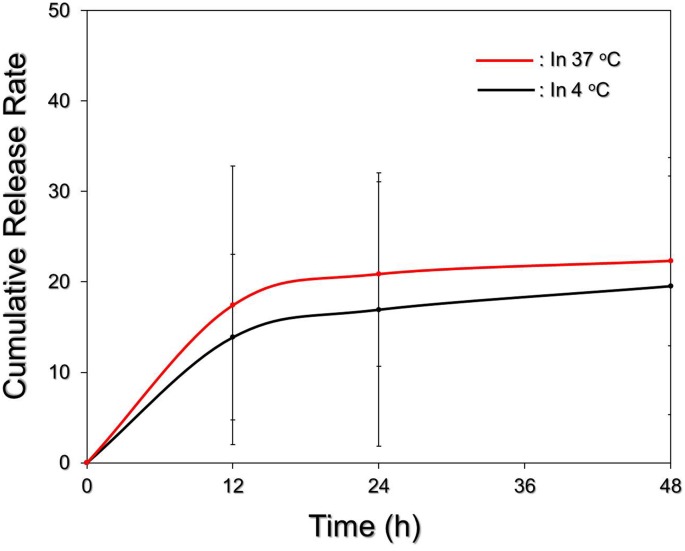
Kinetic release profiles of RIF from the RIPNDs in vitro. The cumulative release curves of the RIPND-entrapped RIF under 4 and 37°C incubation were established by measuring the concentrations of RIF in the supernatant at 0, 12, 24, and 48 h by spectrophotometry (λ = 475 nm). Values are mean ± s.d. (n = 3).